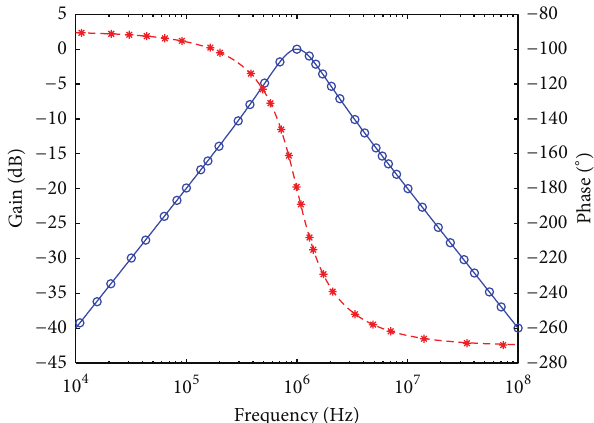
Figure 11: Simulated gain-frequency and phase-frequency respons- es of inverting bandpass filter at 𝑉 𝑜5 ( ∘ : simulated gain; ∗ : simulated phase; — and ---: theoretical curves).